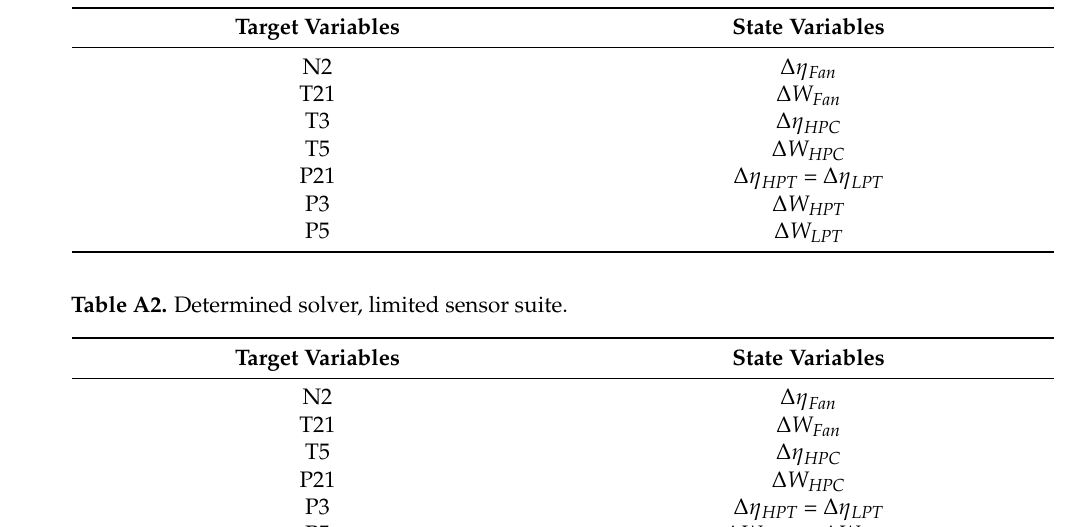
Table A1. Determined solver, full sensor suite.